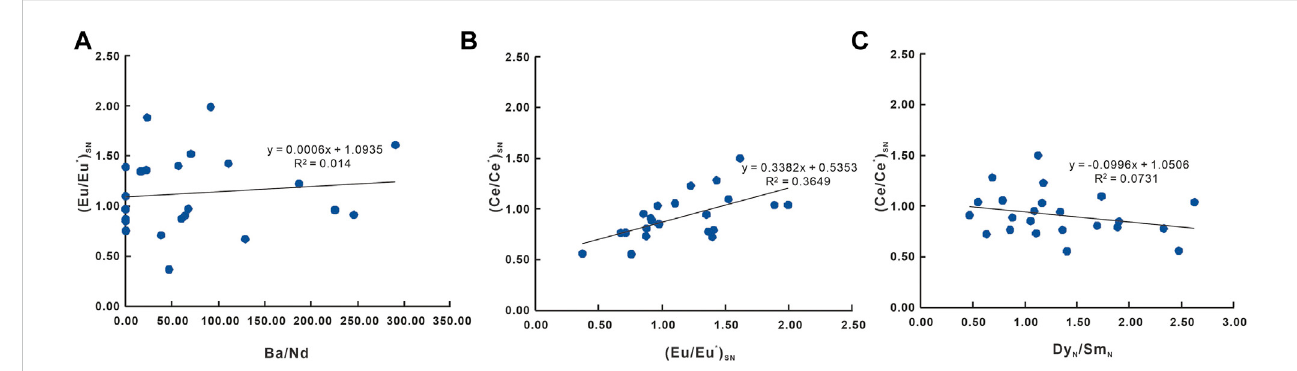
FIGURE 9 Cross-plots showing the correlations of (A) Ba/Nd and (Eu/Eu*) SN values; (B) (Eu/Eu*) SN and (Ce/Ce*) SN values; and (C) Dy N /Sm N and (Ce/Ce*) SN